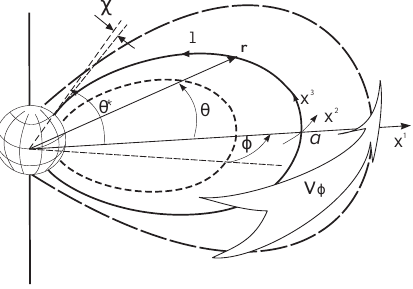
Fig. 1. A model magnetosphere with a dipole magnetic field and azimuthally rotating plasma ( v = ( 0 ,v φ , 0 ) ). Coordinate sys- tems tied to magnetic field lines are shown: a curvilinear orthogonal system of coordinates ( x 1 ,x 2 ,x 3 ) and a non-orthogonal system of coordinates ( a,φ,θ ) used in numerical